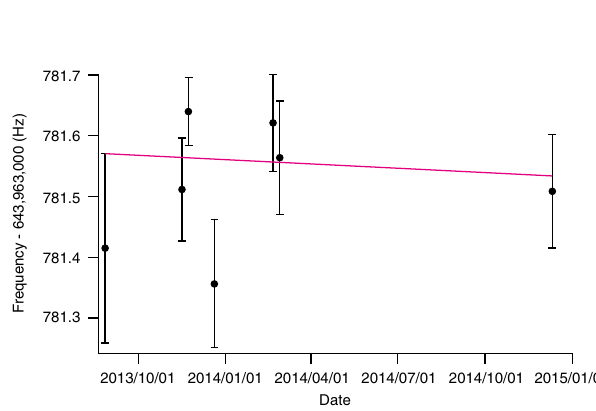
Fig. 4 Measurement of the temporal variation of μ . The resonance frequencies of the |i 〉 − |f 〉 transition are plotted for compensated Zeeman shifts. The error bars denote statistical standard deviations of mean. The magenta line shows a linear fi t to the data with statistical errors. We obtained the temporal variation of the transition frequency f : 1